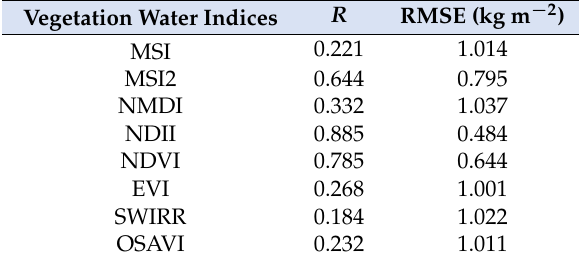
Table 3. Error metrics of vegetation water content (VWC) derived from different vegetation water indices.